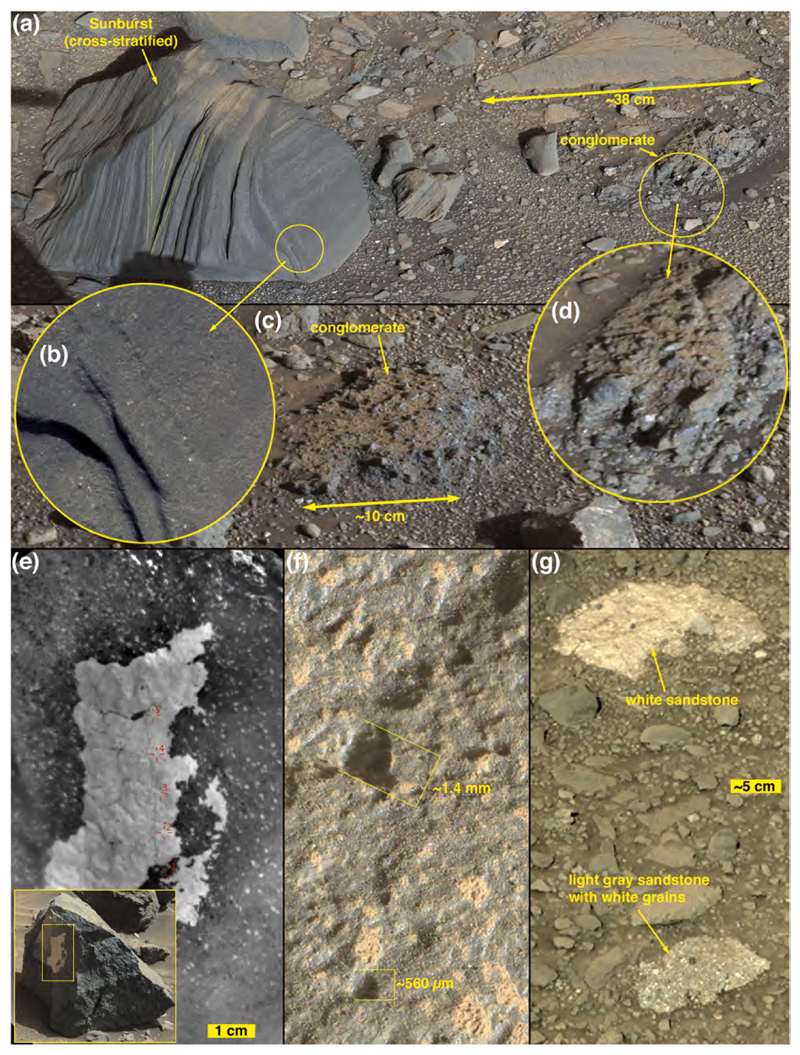
(a) Typical Blackfoot surface, with scattered cobbles, small boulders, pebbles, and sand of various orientations (relative to internal sedimentary structure, such as bedding), colors, and lithologies. Two key examples are highlighted: A cross-stratified sandstone boulder (ChemCam target named Sunburst) and a conglomeratic cobble. (b) Dark-gray sandstone target named Sunburst. White and light-gray sand grains are readily distinguished because of their contrast relative to the majority of grains, which are dark gray. (c) Example of a light-gray conglomeratic cobble, protruding from the surface. The orange-brown material on part of this stone is eolian dust. (d) Pebbles in an otherwise light-gray sandy matrix in a conglomeratic stone protruding from the surface at Blackfoot. (e) ChemCam target Madison; inset shows the image location on the rock face. The large, light-toned feature consists of the remains of a fracture wall vein composed of calcium sulfate. More importantly, the image shows light-toned sand grains, which contrast with the bulk of dark-toned sand grains (much more difficult to see) in this rock. Madison is a dark-gray sandstone. (f) APXS/MAHLI target, Badlands. This stone, too, is a dark-gray sandstone. Unlike Madison and Sunburst, Badlands has no light-toned sand grains; they are all dark gray. The sizes of two larger grains are indicated; most grains are smaller and difficult to distinguish from each other and their intergranular cement. Brownish-orange patches are depressions (some of them, perhaps, may be sockets from which sand grains have been removed) containing eolian dust. (g) Two examples of the light-toned sandstone or pebbly conglomerate fragments which occur at Blackfoot. (For interpretation of the references to color in this figure, the reader is referred to the web version of this article.)